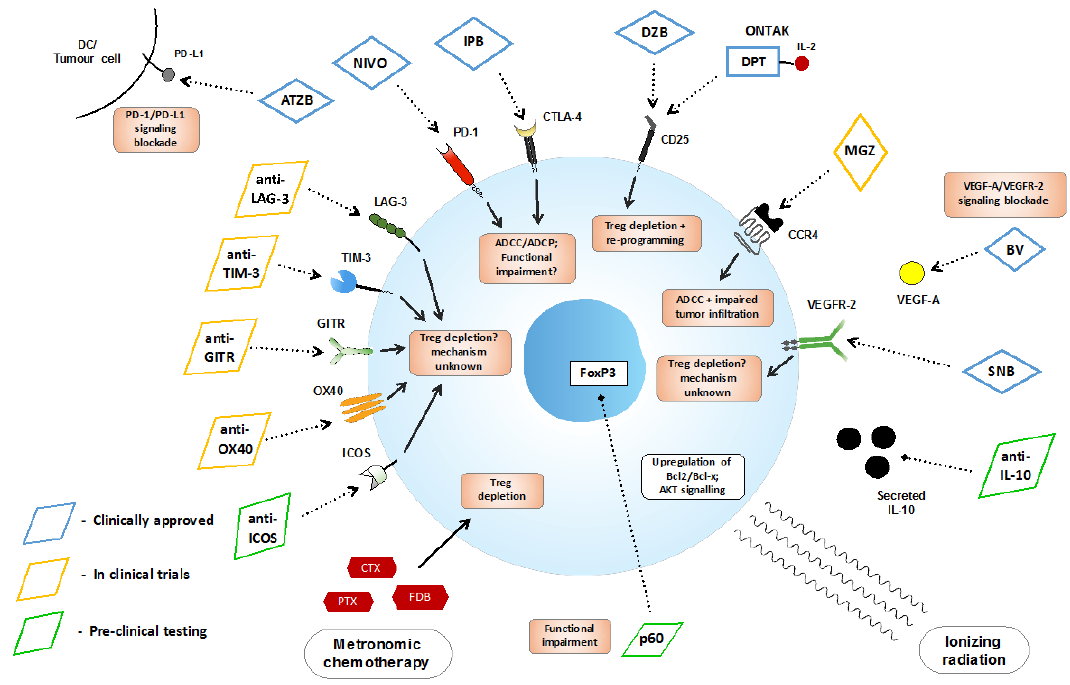
Figure 1. Summary of currently approved and experimental therapies that may target Tregs; therapies are color-coded according to stage in clinical testing. Abbreviations—ADCC: antibody-dependent cell-mediated cytotoxicity, ADCP: antibody-dependent cellular phagocytosis, ATZB: atezolizumab, BV: bevacizumab, CTX: cyclophosphamide, DC: dendritic cell, DZB: daclizumab, CCR4: C-C motif